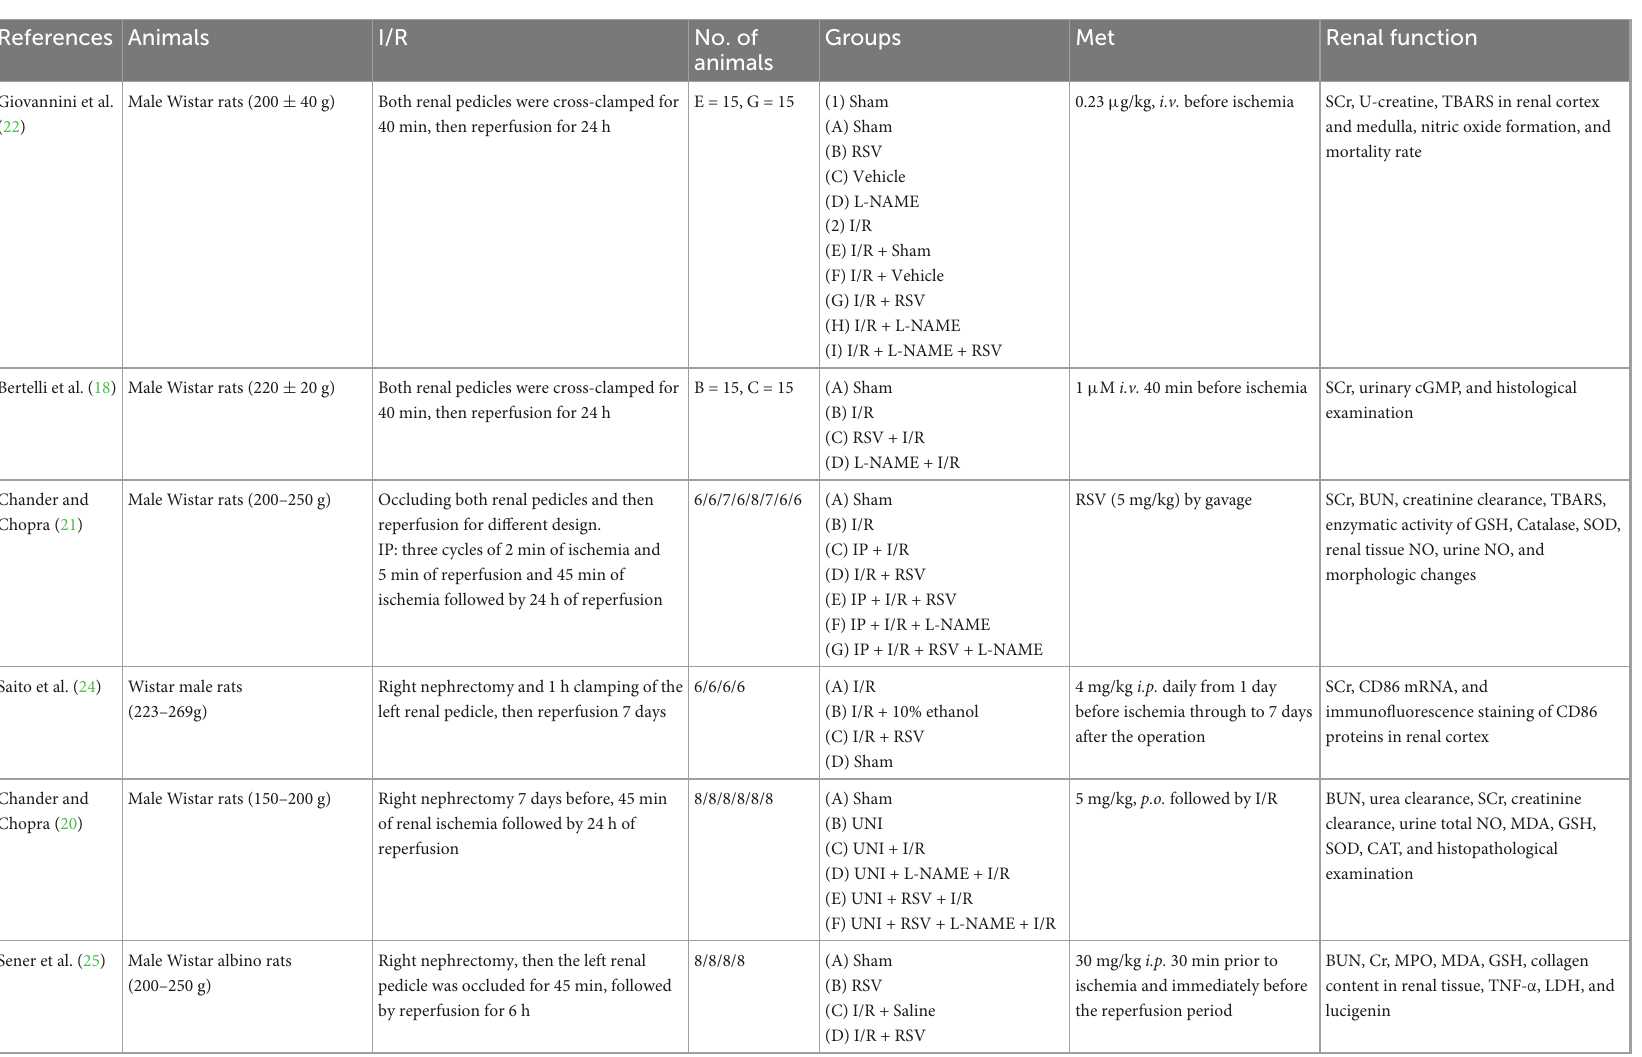
TABLE 1 Characteristics of the studies included in the